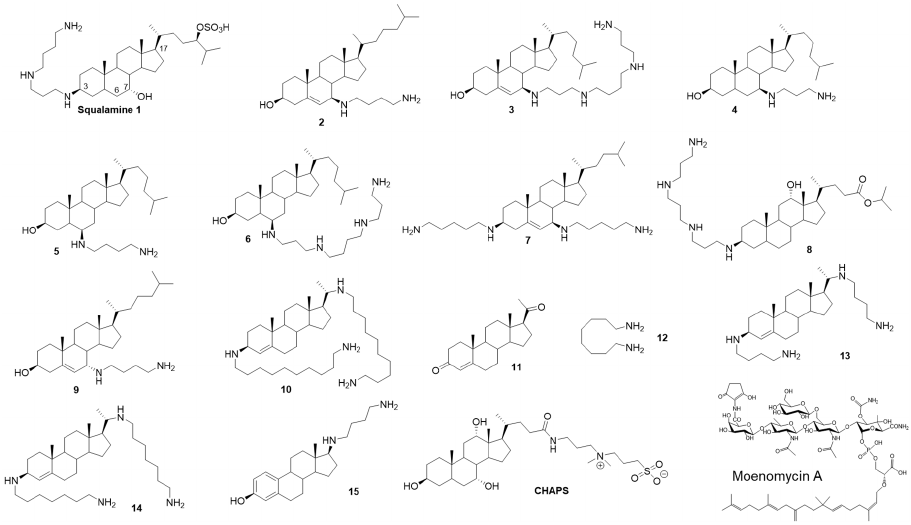
Figure 1. Structures of the aminosterol compounds used in this study and moenomycin